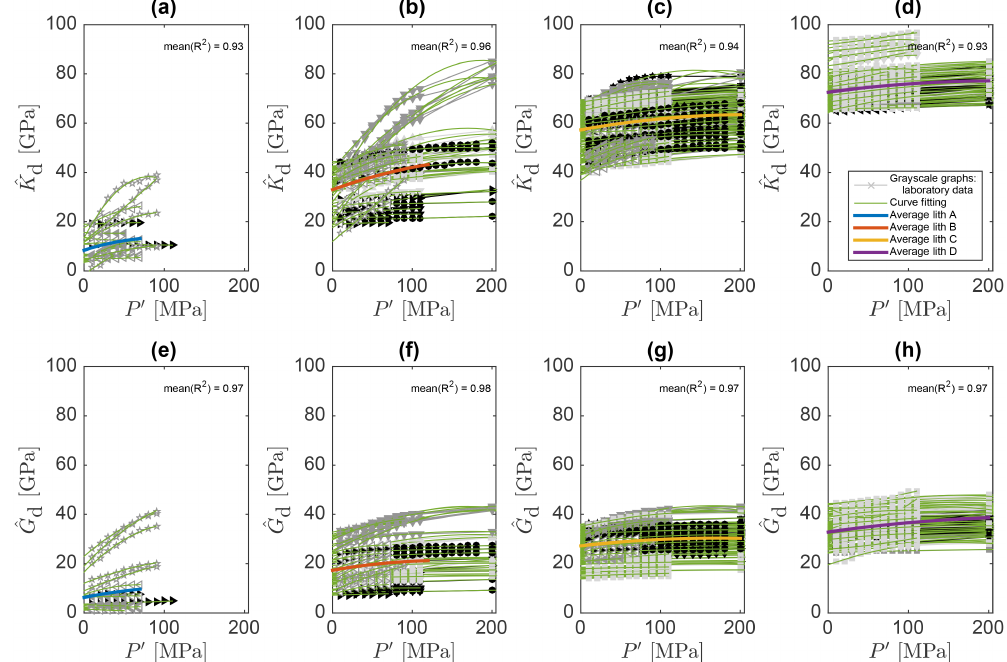
Figure 7. Drained elastic bulk modulus (a–d) and shear modulus (e–h) versus effective confining pressure. Gray and black curves are experimental data reported in the literature (see references in Fig. 4), green curves show fitted functions (according to Eqs. 23 and 24, with average goodness of fit as indicated by the R 2 values) and the thick color-coded graphs represent average trends taken for lithologies A–D.